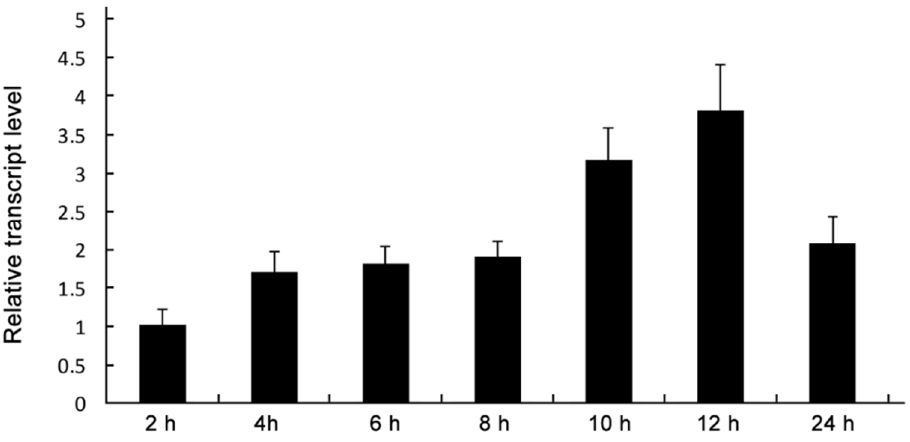
Figure 3. Sequential expression of MoDXH35 . Relative transcript abundance of MoDXH35 during conidial germination and appressorial formation. The transcript abundance normalized to β‐ tubulin gene (MGG_00604) was measured by quantitative RT-PCR at time points and compared to that in the non-incubated